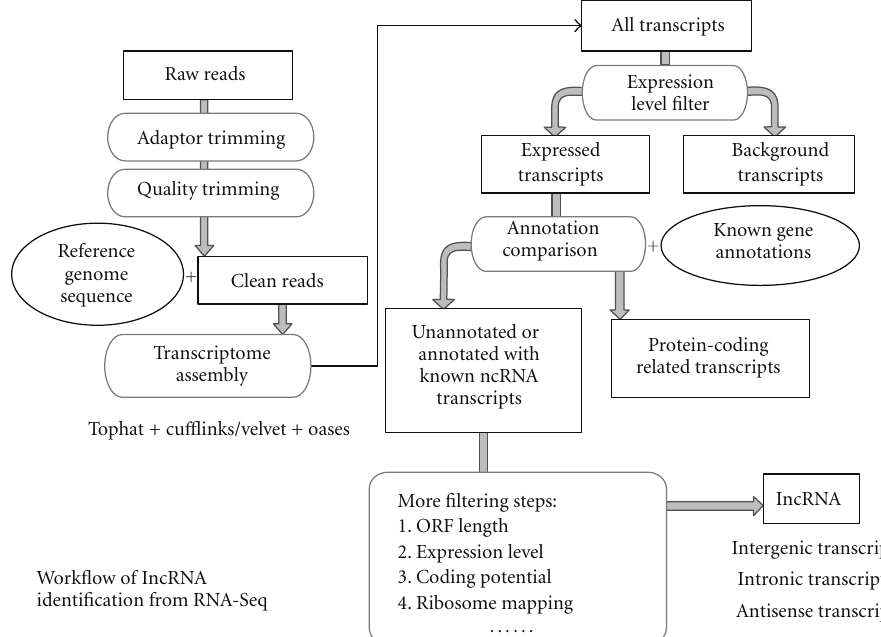
Figure 1: Workflow of lncRNA identification from